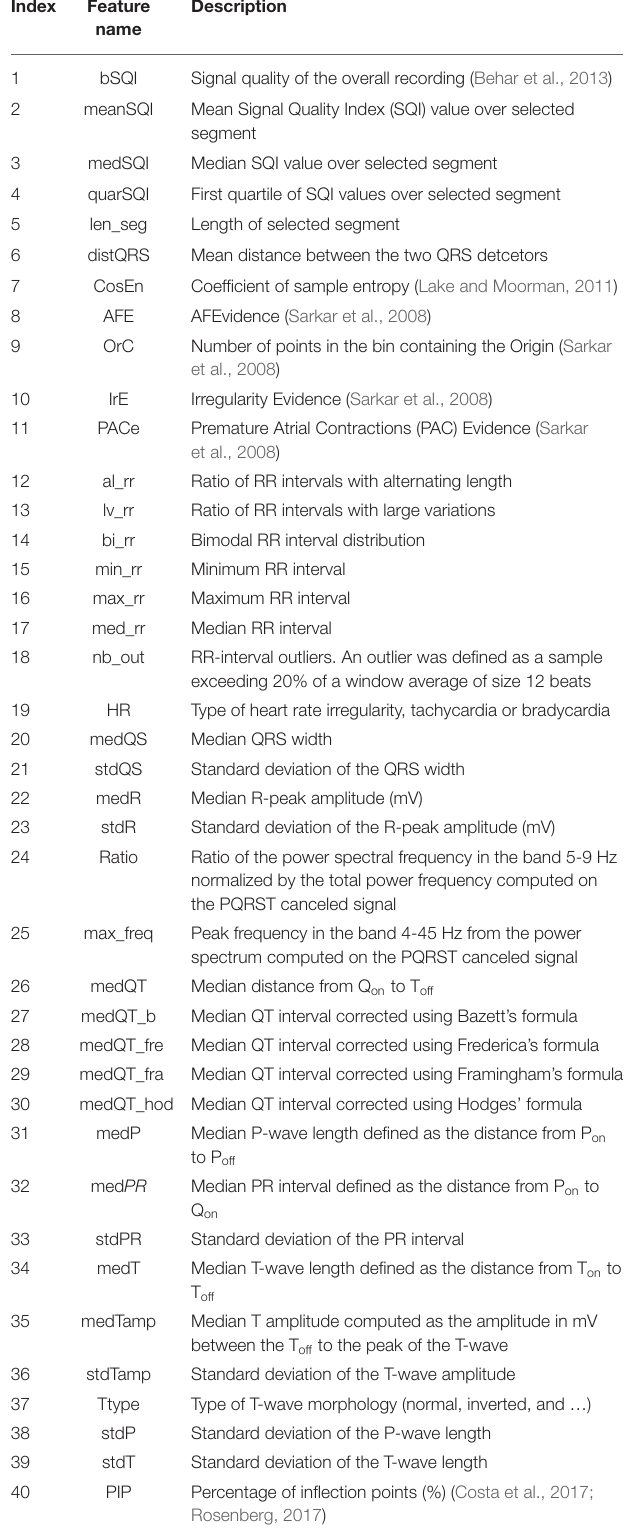
TABLE 1 | List of features extracted from ECG